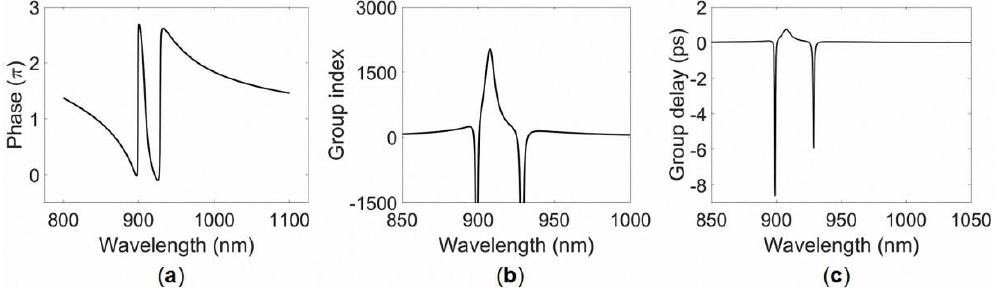
Figure 5. Simulated transmission phase shift ( a ), group index ( b ), and group delay ( c ) of the dielectric metamaterial with geometrical parameters are the same as shown in Figure 1b.